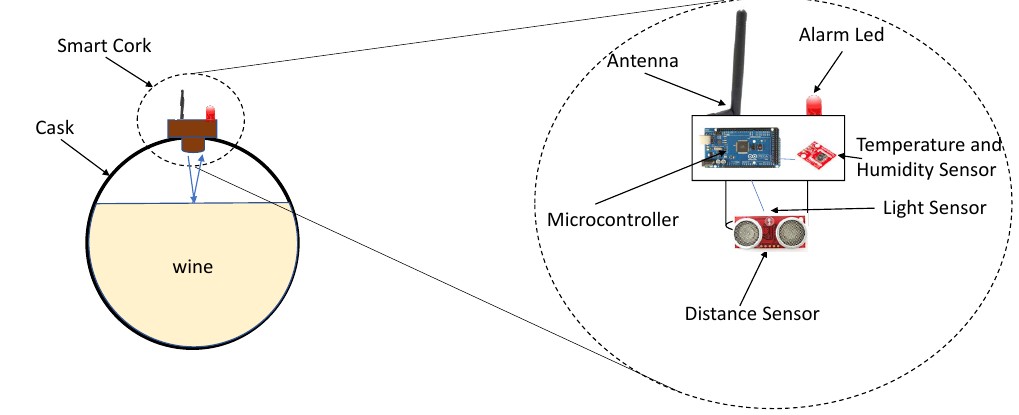
Figure 6. Smart cork hardware architecture.